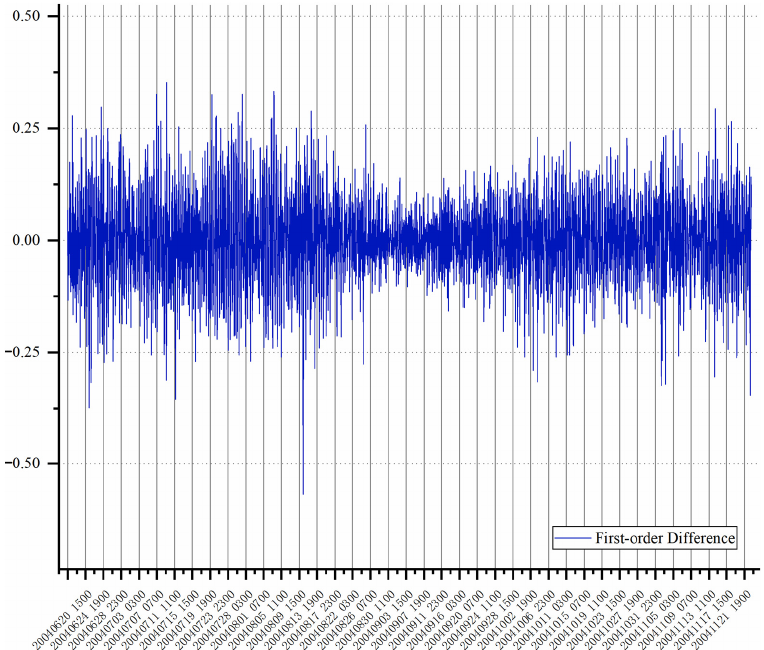
Figure 8. First-order transformation data of temperature data of KEO station at 400 m underwater. After the first-order difference, the change in temperature data tends to be stable.